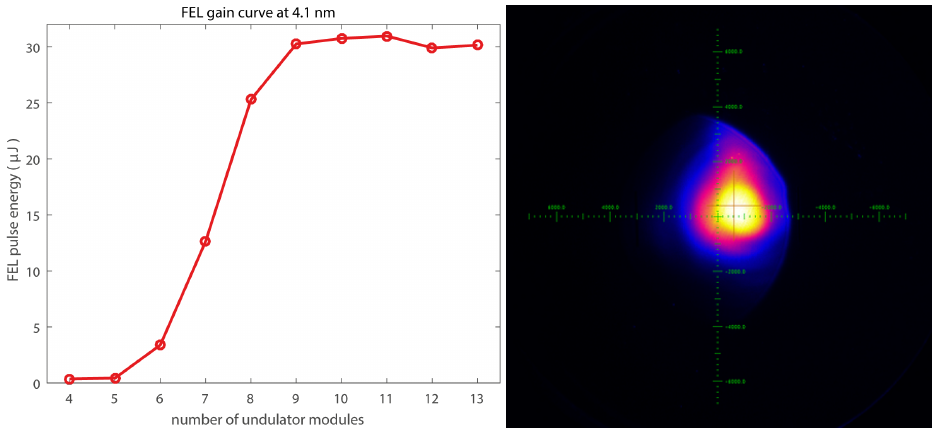
Figure 5. Measured SwissFEL pulse energy gain curve as a function of inserted undulator modules at an electron energy of 900MeV (left). Saturation is reached after insertion of 9 modules. Pulse energy measured with the gas-based photon beam intensity and position monitor (see Section 3.3.1). An image of the photon beam at saturation, as recorded with a Ce:YAG scintillating screen, is shown on the